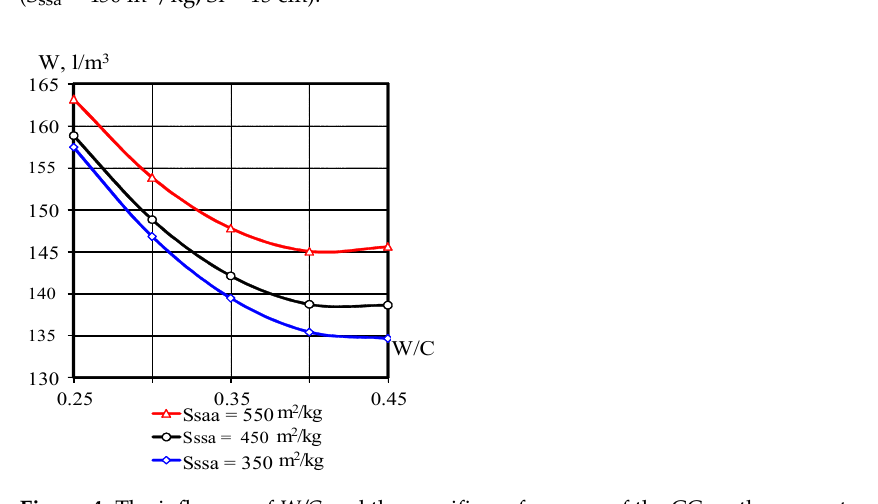
Figure 4. The influence of W/C and the specific surface area of the CC on the concrete mixture water consumption (PFM 1 = 0.7%, Sl = 13 cm).